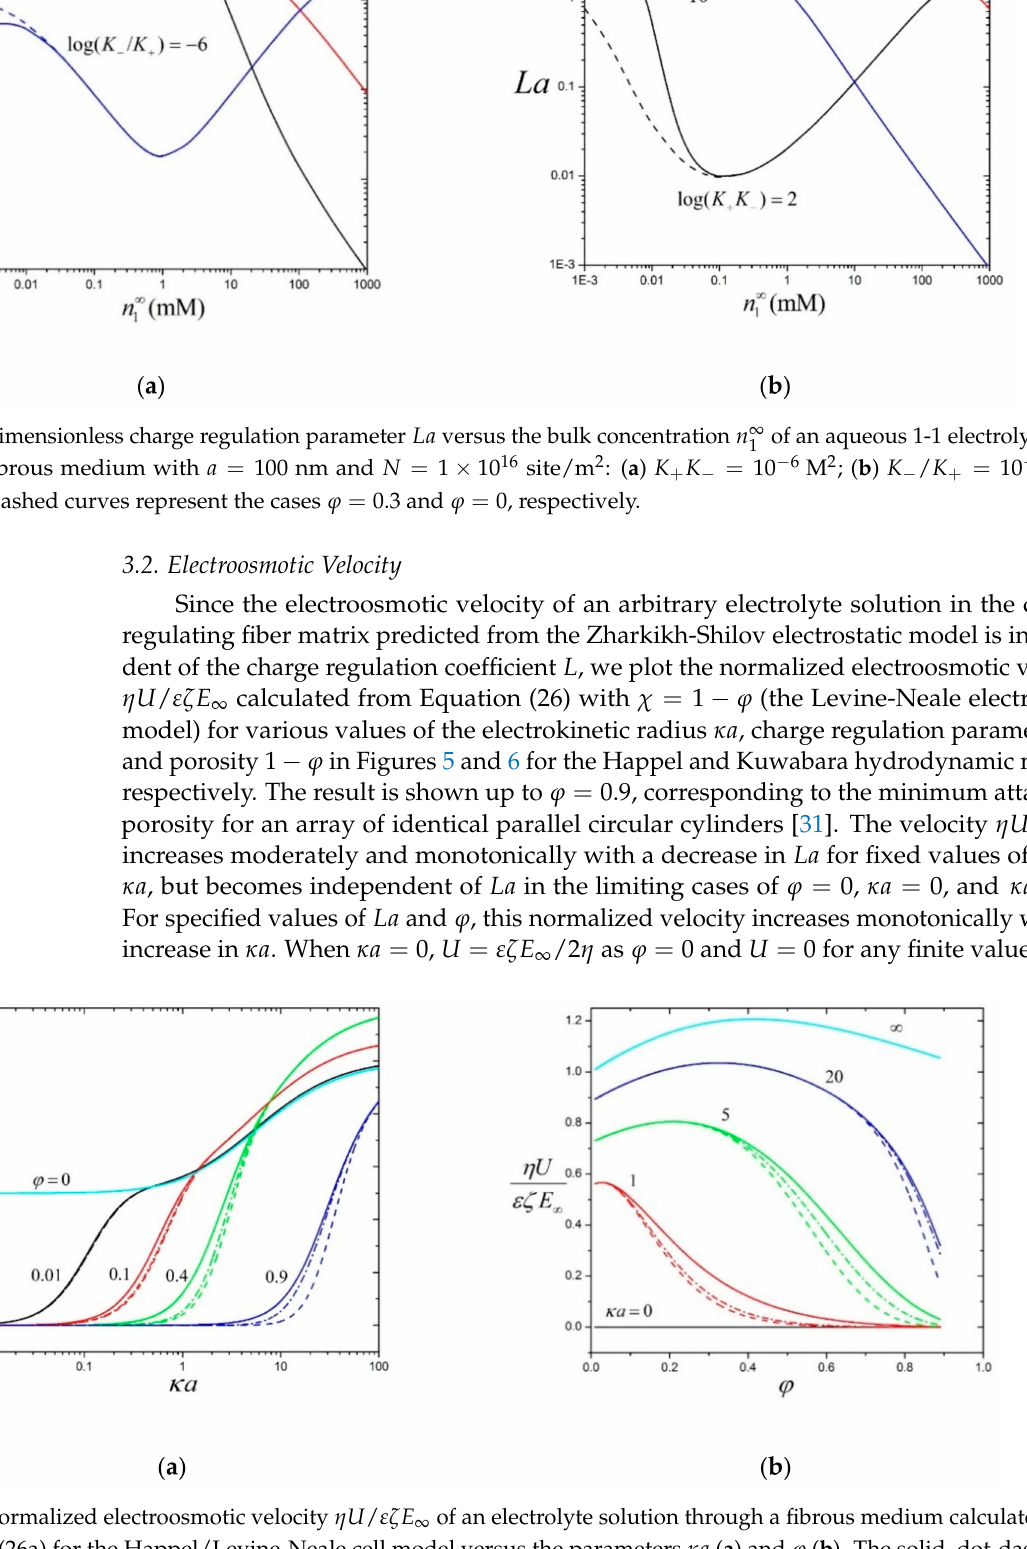
of an aqueous 1-1 electrolyte 1